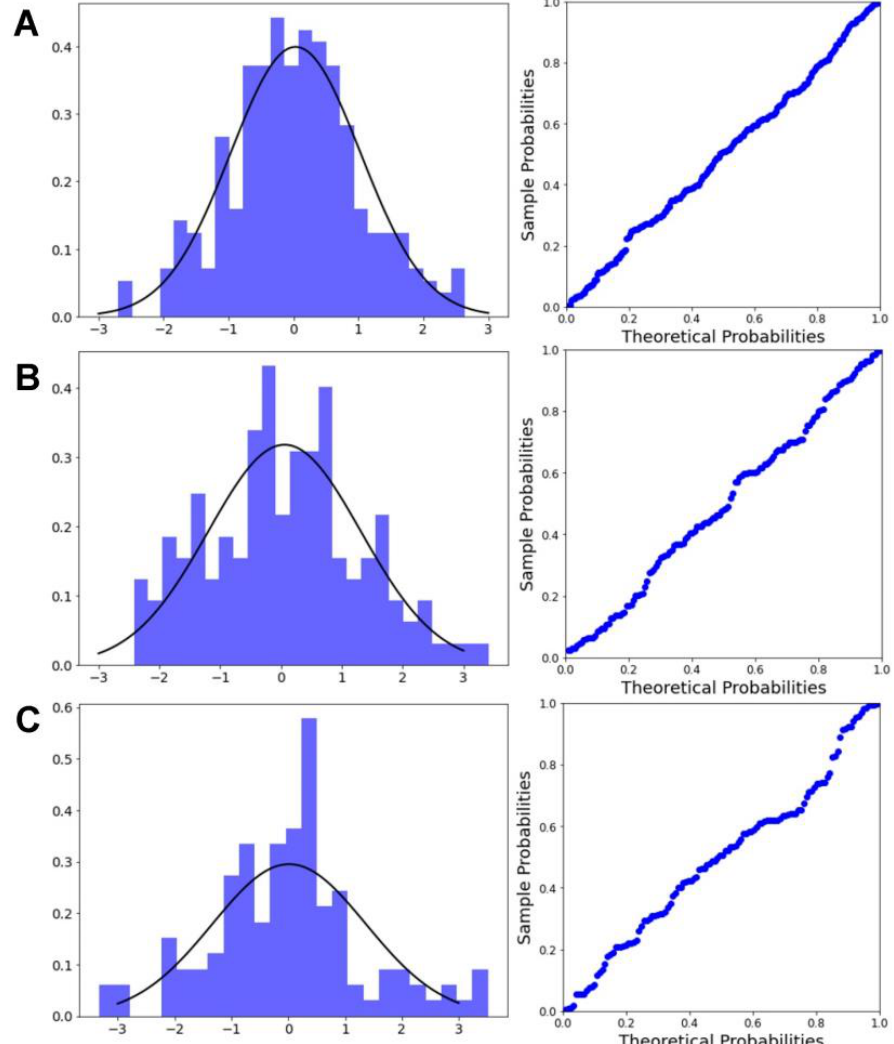
Figure 7. Histogram of the standardized residuals and the probability – probability (p-p) plots for ( A ) all soils, ( B ) sandy soils, and ( C ) clayey soils. The second graphical technique applied was a p-p plot. This type of plot compares the empirical cumulative distribution function with the theoretical cumulative distribution function. Moreover, this plot can also show whether the residuals or errors follow the assumed normality. Points on the p-p plot must follow the 1:1 diagonal line for normally distributed data. Finally, the measured V s and estimated V s from each empirical correlation were compared, in order to assess the performance of the regression models (Figure 8). Data pairs mostly lay in the region between the lines 1:1.50 and